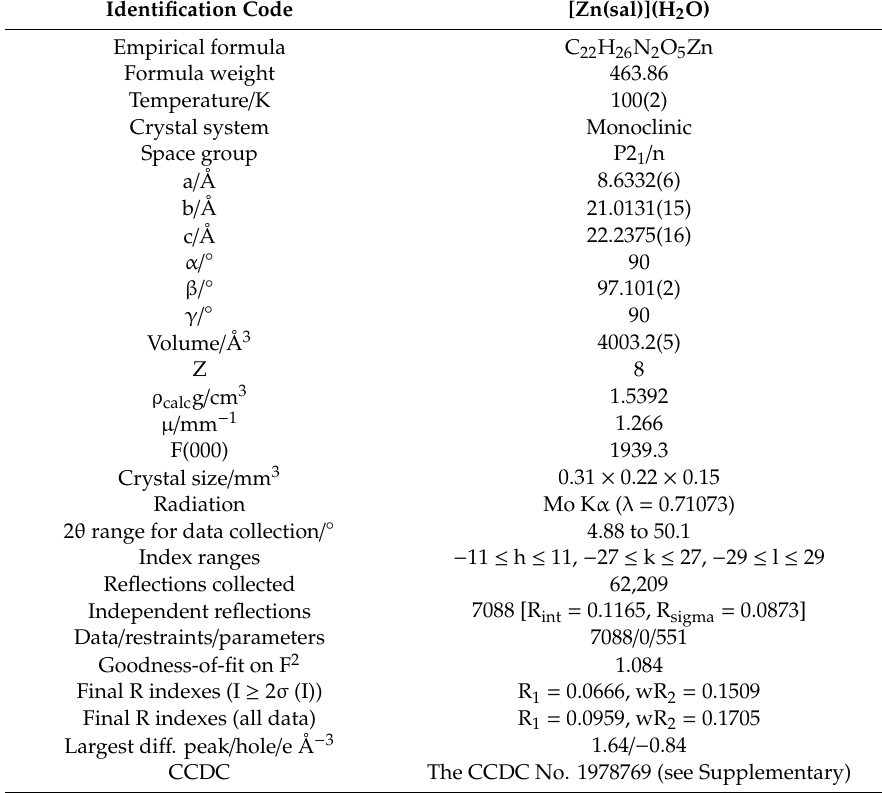
Table 1. Crystal data and structural refinement for the [Zn(sal)](H 2 O)